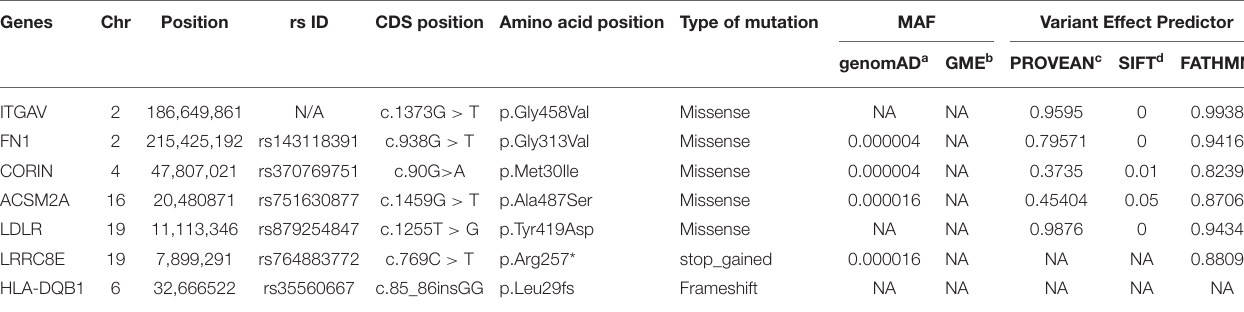
TABLE 1 | List of potential candidate rare variants the in consanguineous family with EO-IBD. Genes Chr Position rs ID CDS position Amino acid position Type of mutation MAF Variant Effect